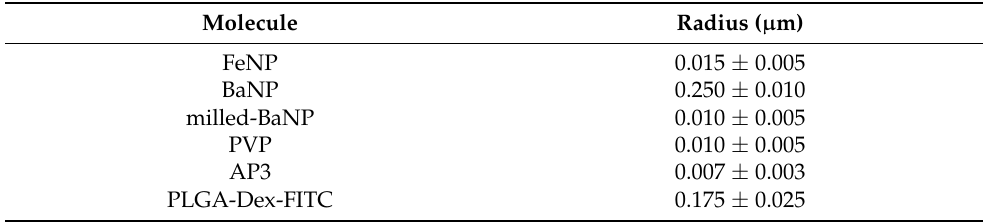
Table 1. Radii of single magnetic nanoparticles (MNPs) and surface modification molecules ( r m and r n ). Particle sizes and uncertainties were estimated from transmission electron microscopy (TEM) images or size distribution plots given in Ref.